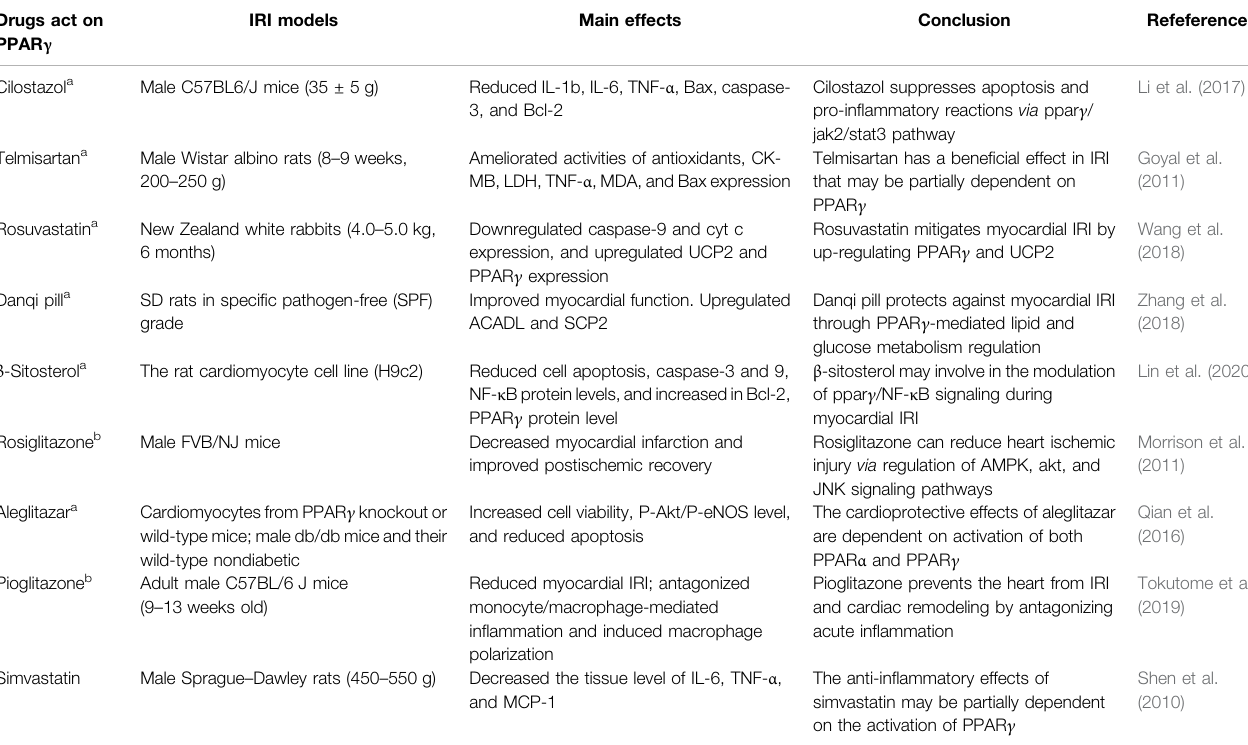
TABLE 4 | Summarization of the effects of drugs acting on PPAR γ in myocardium